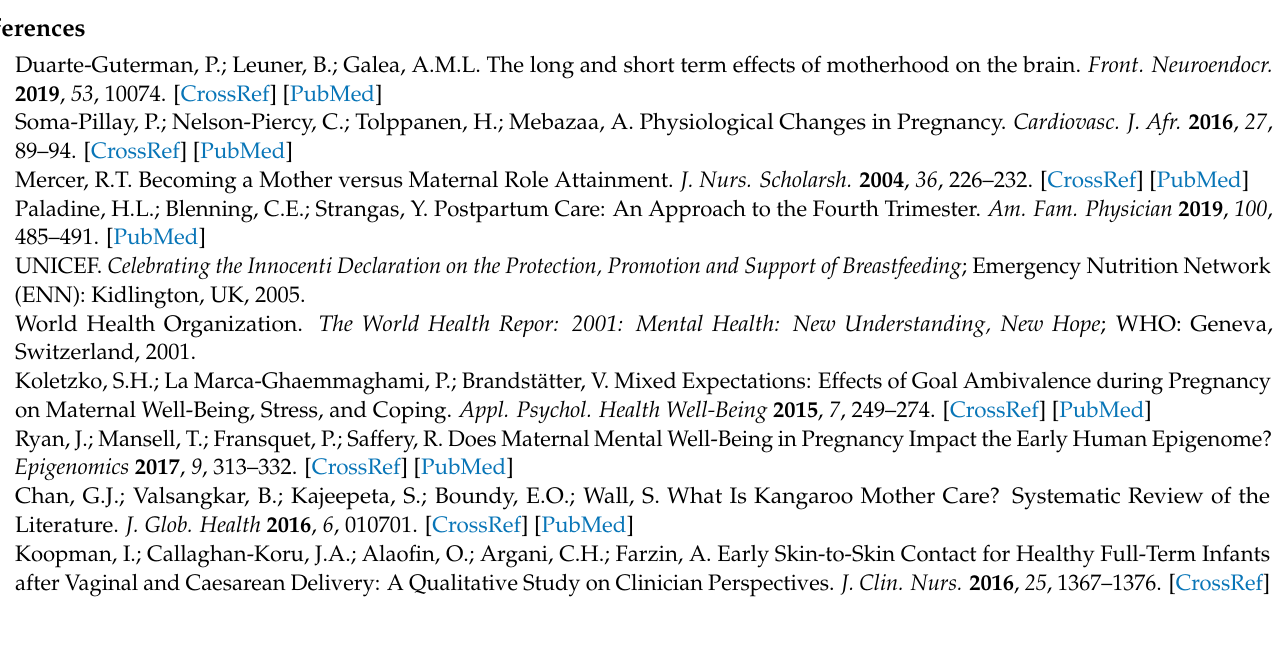
Table S6: Recommendations concerning rooming-in management for mothers with confirmed and/or suspected